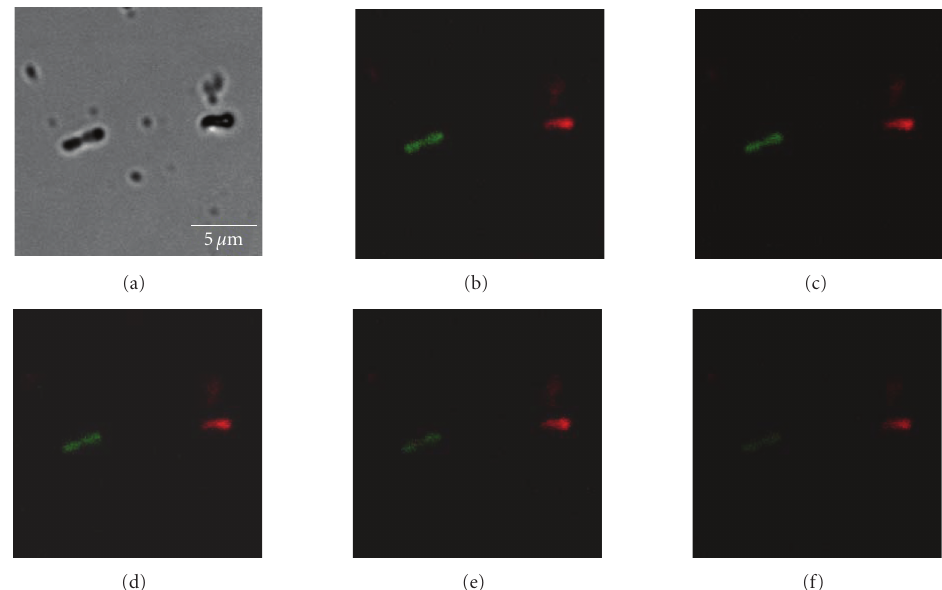
Figure 5: Photostability comparing of the fluorescent nanoparticles labeled on M. tuberculosis and FITC dyes labeled on E. coli. A mixture containing 1 . 8 × 10 6 cells/ml FITC-labeled E. coli and 3 . 6 × 10 5 cells/ml unlabeled M. tuberculosis was detected with the FNP-IIFM method. The slide was successive irradiated with an intensive argon/krypton laser under the confocal microscope (60 × oil) for (a) and (b) 0 second, (c) 1 minute, (d) 2 minutes, (e) 4 minutes, (f) 6 minutes. (a) Transmission image, (b)–(f) Fluorescence images. Green: E. coli ; Red: M. tuberculosis . The fluorescence of FITC was dim after being continuously irradiated for 2 minutes while that of the nanoparticles was still